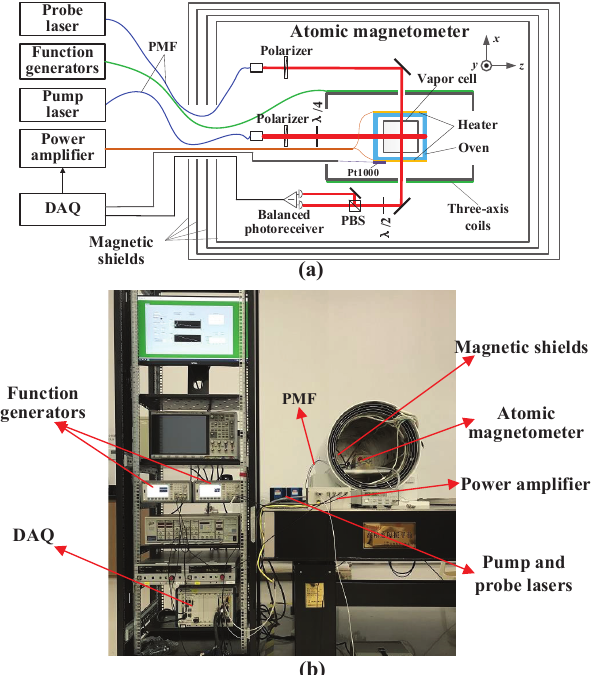
Figure 2. Schematic ( a ) and photograph ( b ) of the experimental setup of the SERF atomic magnetometer. PMF: polarization maintaining optical fiber; DAQ: data